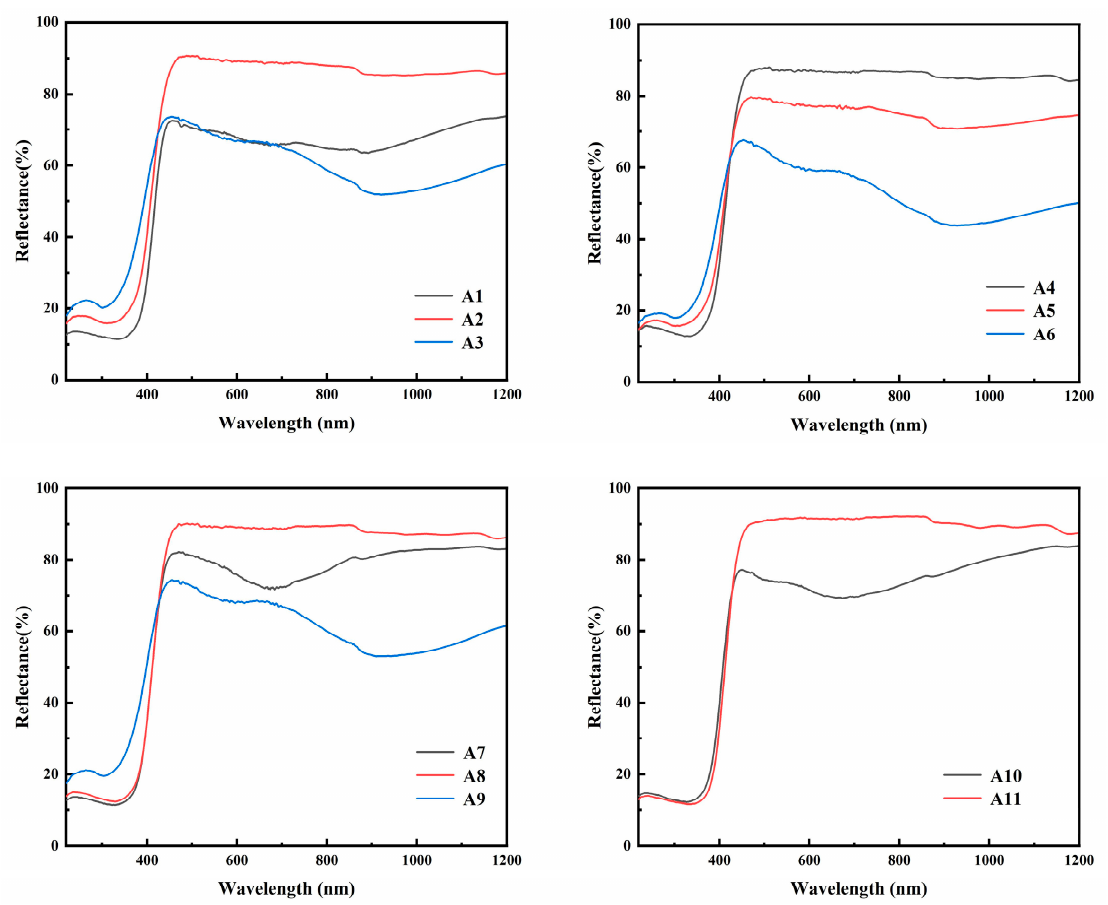
Figure 7. UV–Vis diffuse reflectance spectra of samples Figure 7. UV–Vis di ff use re fl ectance spectra of samples A1–A11.